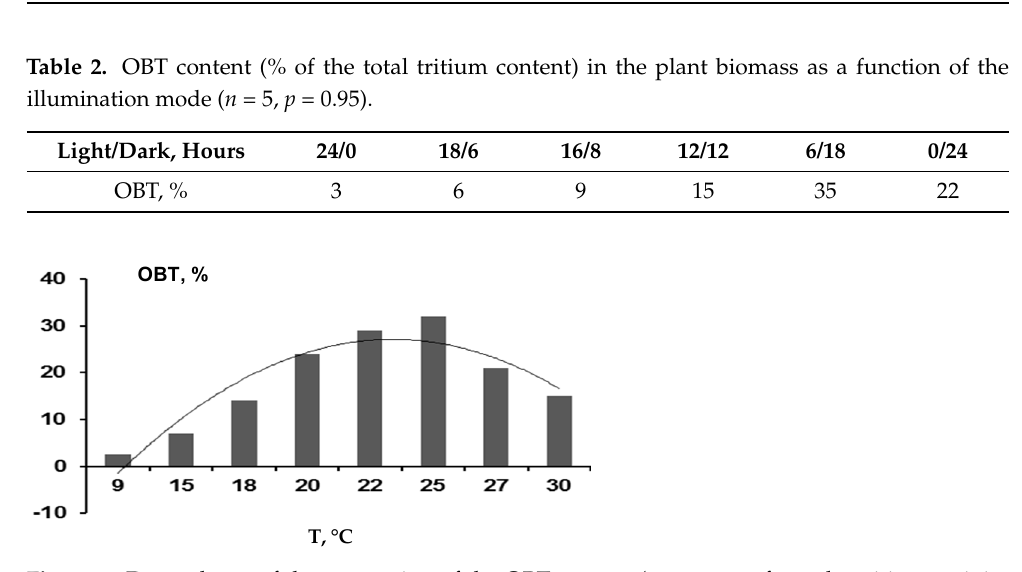
Table 1. Results of tritium content estimation and its distribution with regard to the forms of bind- ing to the Elodea biomass ( n = 10, p = 0.95).